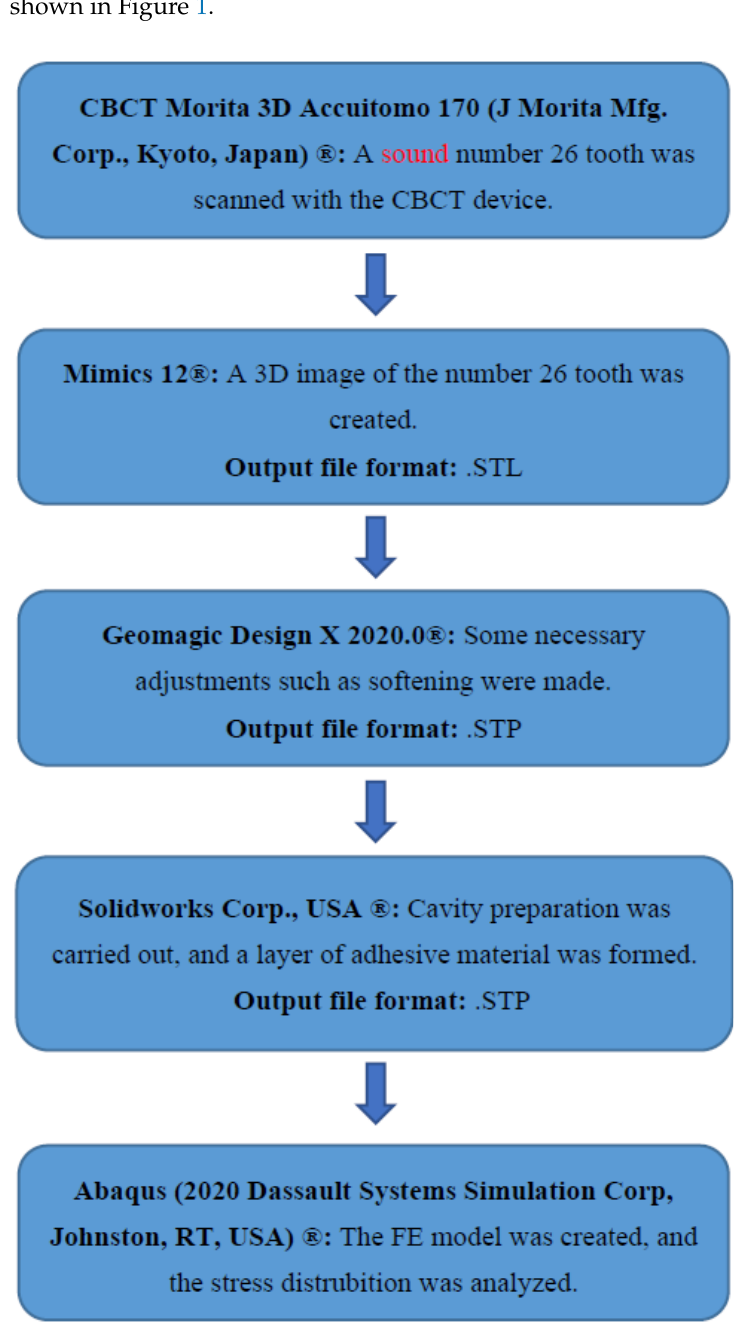
Figure 1. Sequential set of equipment and software used for finite element stress